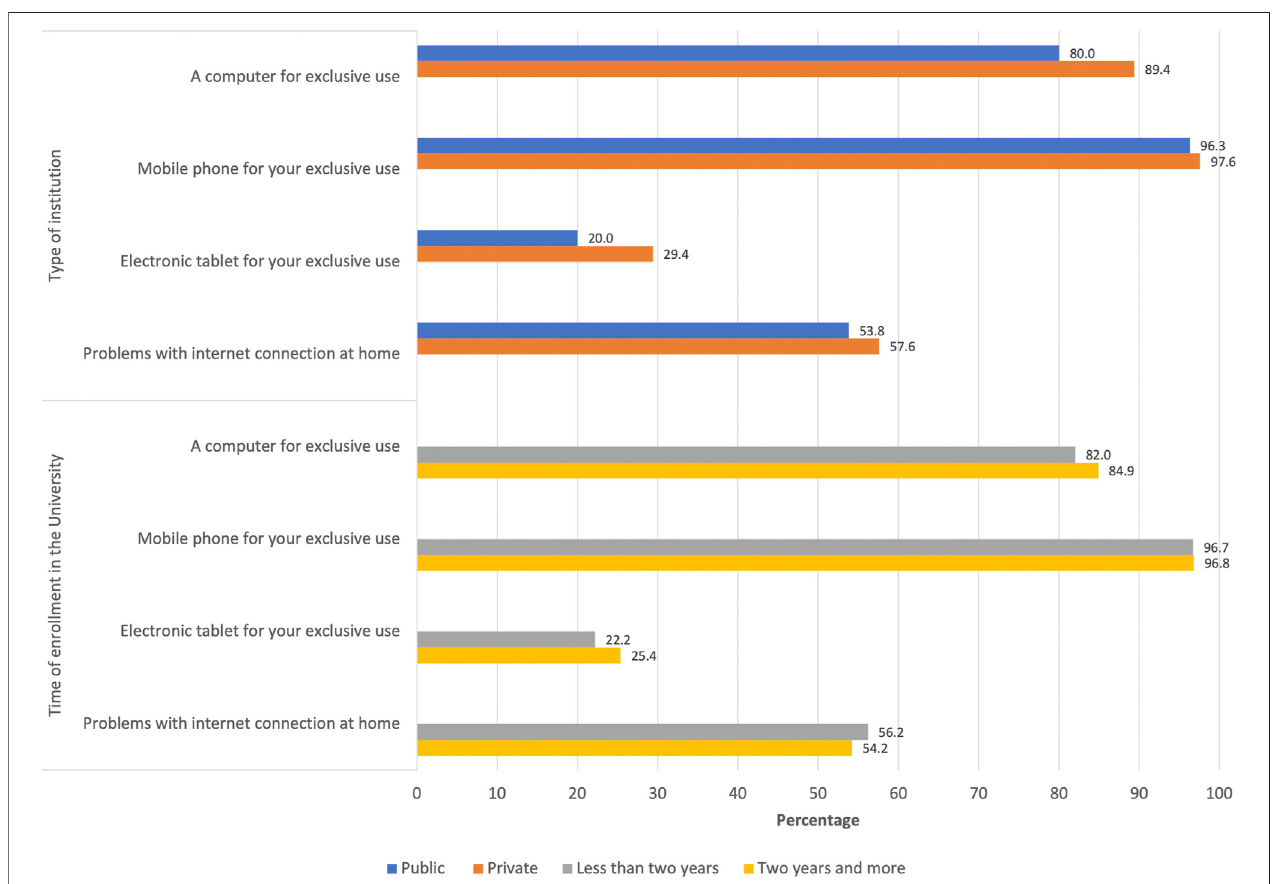
FIGURE 4 | Technological and connectivity conditions among students during the emergency remote teaching model implementation, by type of institution and time of enrollment in the university.